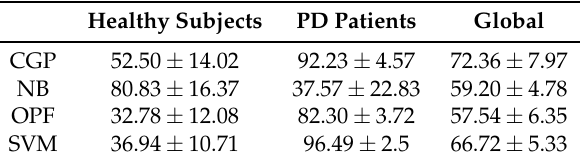
Table 5. Recognition rates per class and global accuracy ( mean ± sd ) for the meander dataset.